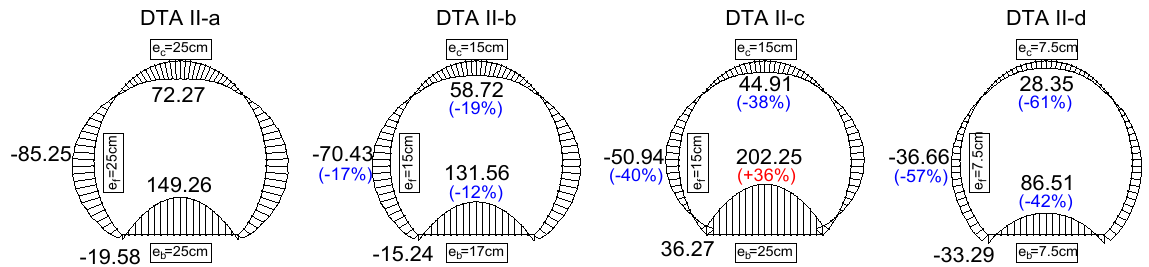
Figure 14. Comparison of the bending moments (kN·m) for DTA II culvert (H = 10m)